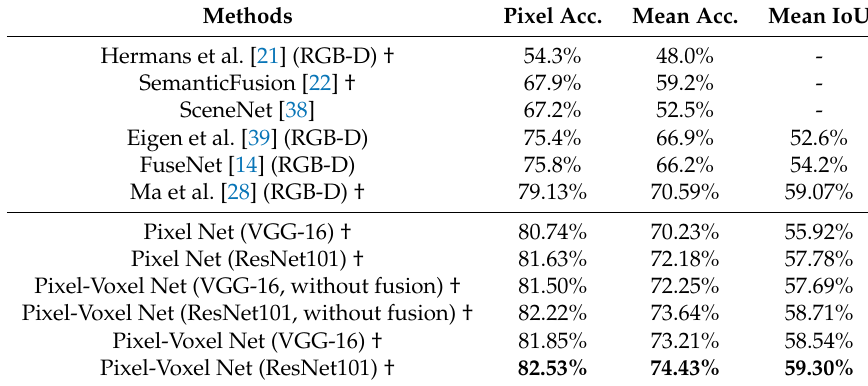
Table 2. Comparison of overall performance on the NYU V2 dataset. Some results are copied from [28]. The methods with † take advantage of the data from multiple views. The best performance among the compared methods is marked as